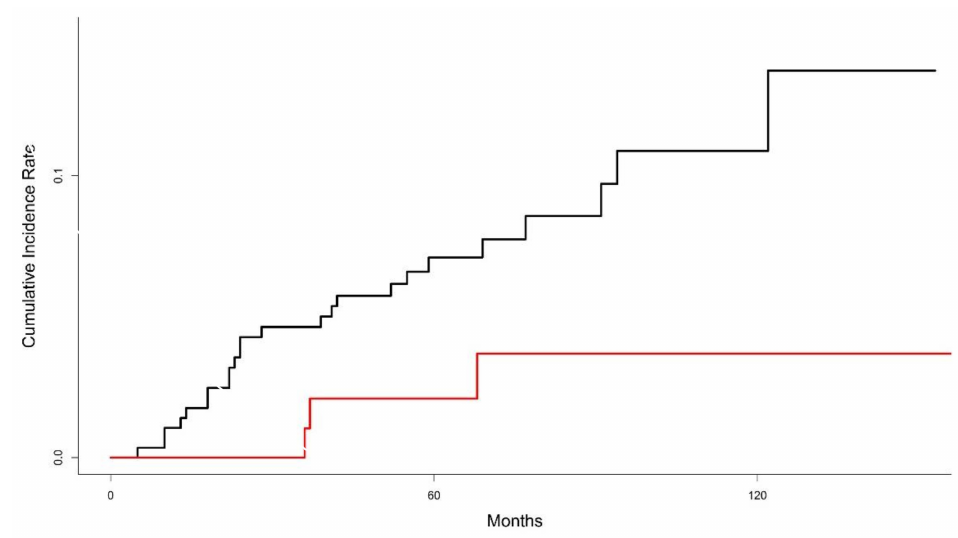
Figure 1. Graph of cumulative incidence of local recurrence between breast conservation therapy (black line) and mastectomy alone (red line).